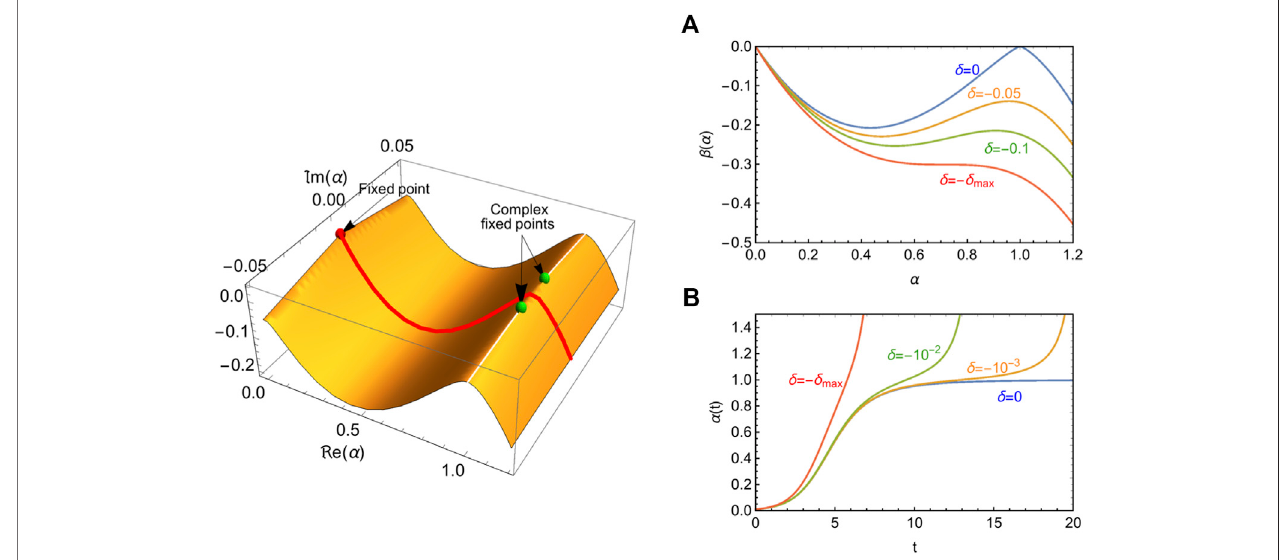
(cid:5)(cid:5)(cid:5)(cid:5) (cid:5)(cid:5)(cid:5)(cid:5) β ( α ) )extendedtothecomplexplane,